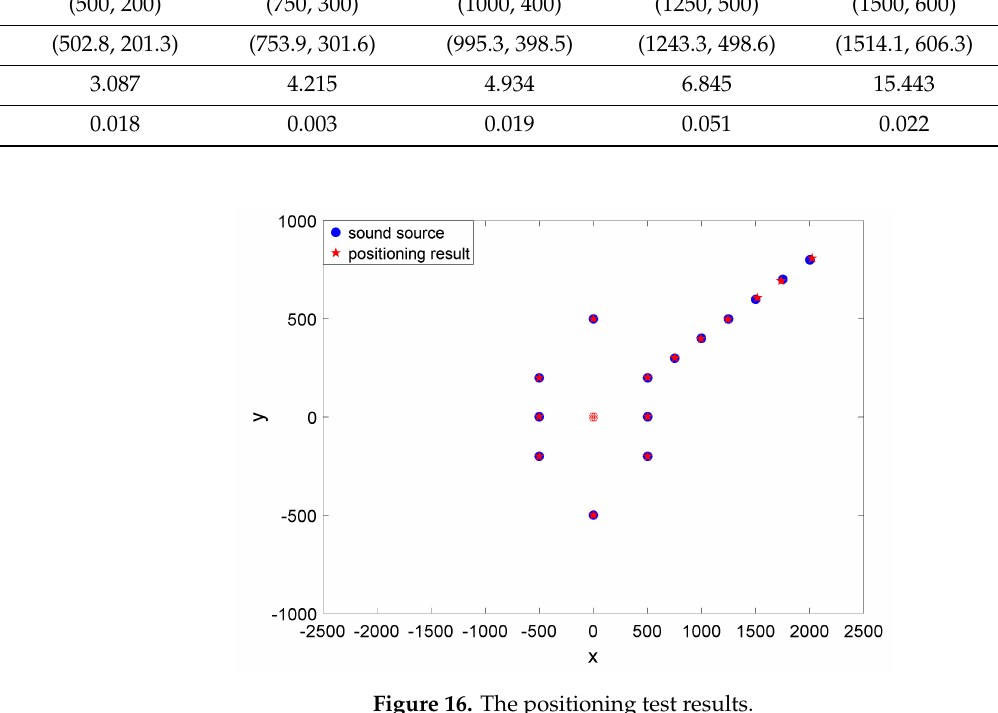
Figure 16. The positioning test